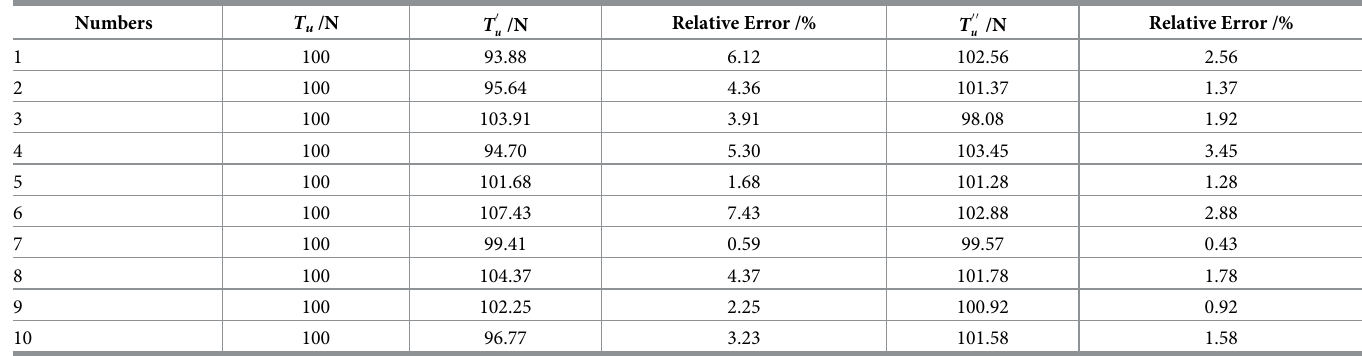
Table 5. Comparison Table of unwinding tension